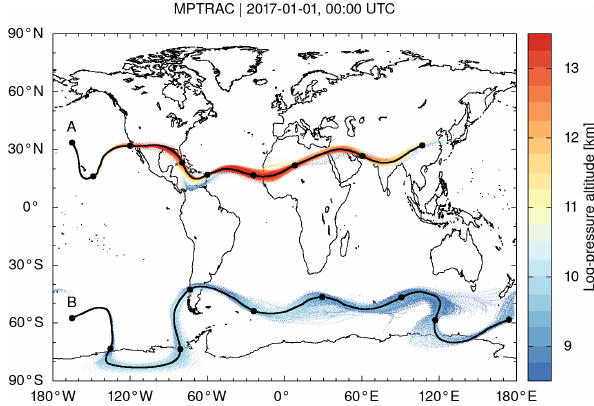
Figure 2. Trajectory calculations for the Northern Hemisphere sub- tropical jet (case A) and the Southern Hemisphere polar jet (case B) from 1 January 2017, 00:00UTC, to 9 January 2017, 00:00UTC. Trajectories were launched at positions A and B at log-pressure al- titudes of 11.25 and 8.5km, respectively. Calculations used hourly ERA5 horizontal winds and vertical velocity data for input. Black curves show trajectories calculated without diffusion. Black dots in- dicate 24h time intervals. Colored dots show calculations for two sets of 1000 trajectories for cases A and B with turbulent diffusion and subgrid-scale wind fluctuations being